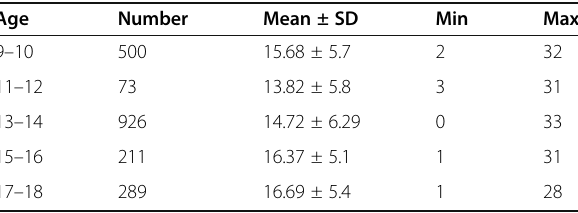
Table 3 Distribution of emotional and behavioral problems by age in the student city of